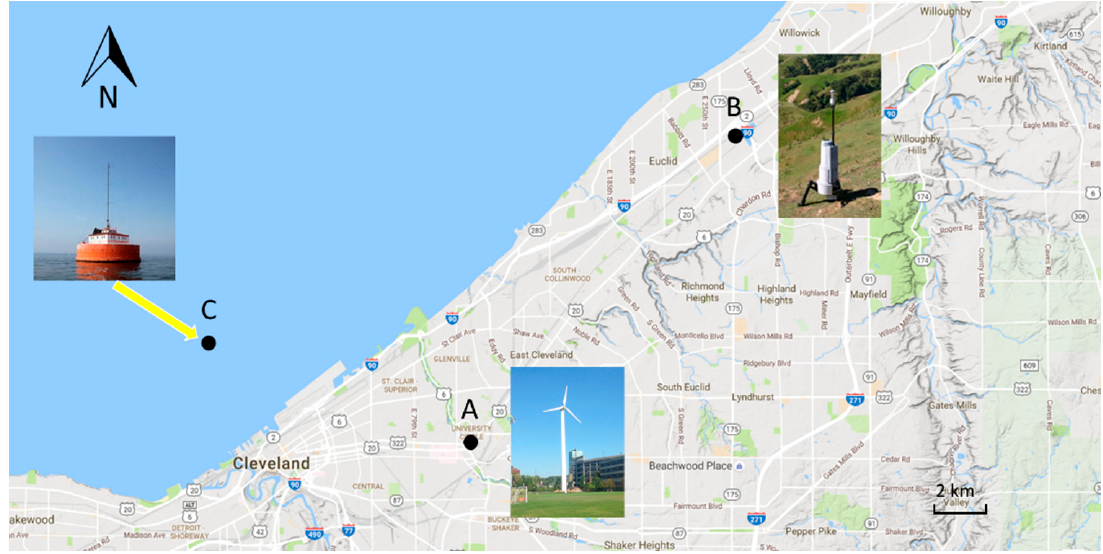
Figure 6. Location of selected sites with wind condition measurement.